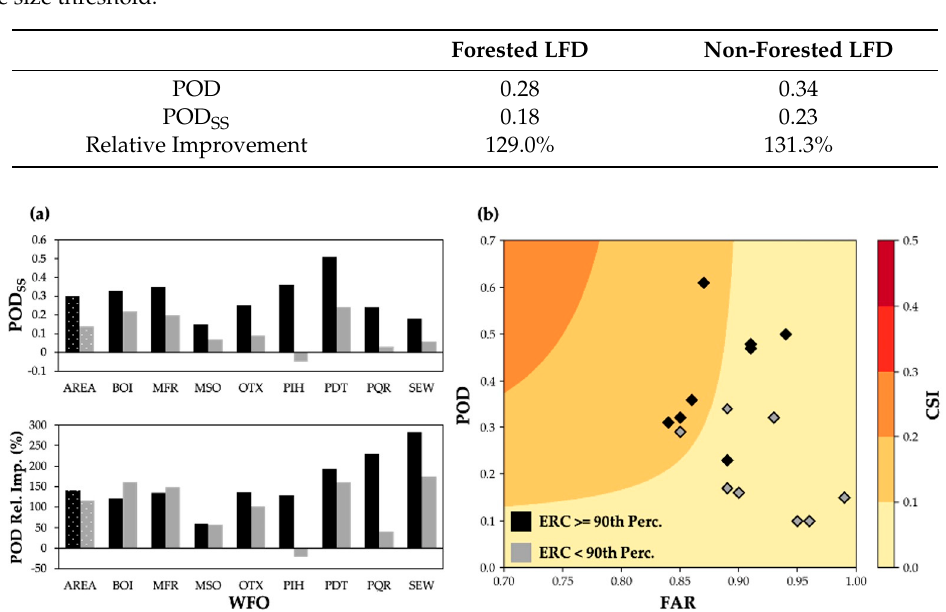
Table 4. As in 3a but for forested and non-forested large fire land cover types using a 90th percentile fire size threshold.